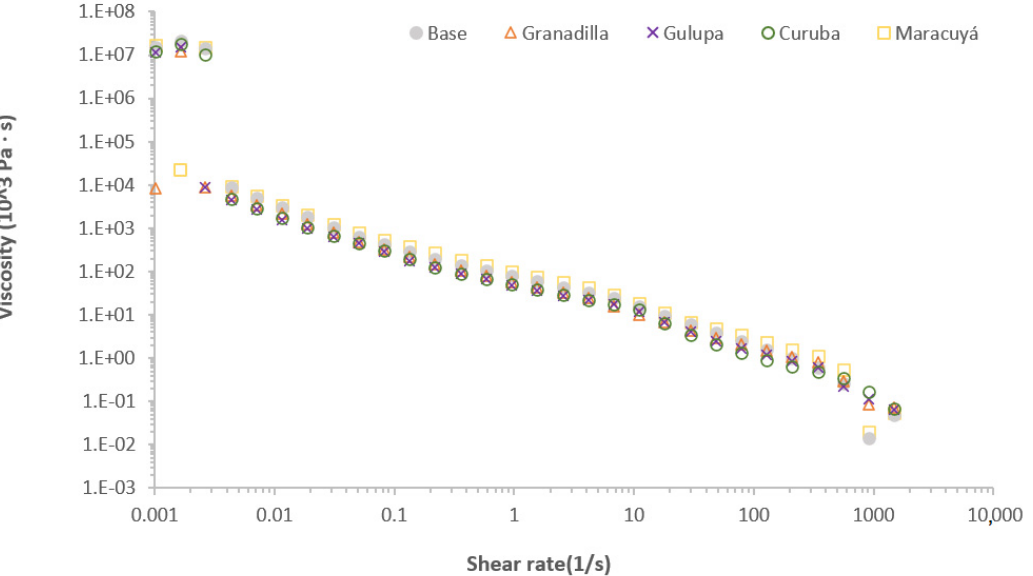
Figure 4. Viscosity profile of exfoliant prototypes. “Granadilla” ( Passiflora ligularis ), “gulupa” ( P. edulis Sims fo edulis ), “curuba” ( P. mollissima ), and “maracuyá” ( P. edulis , reference).